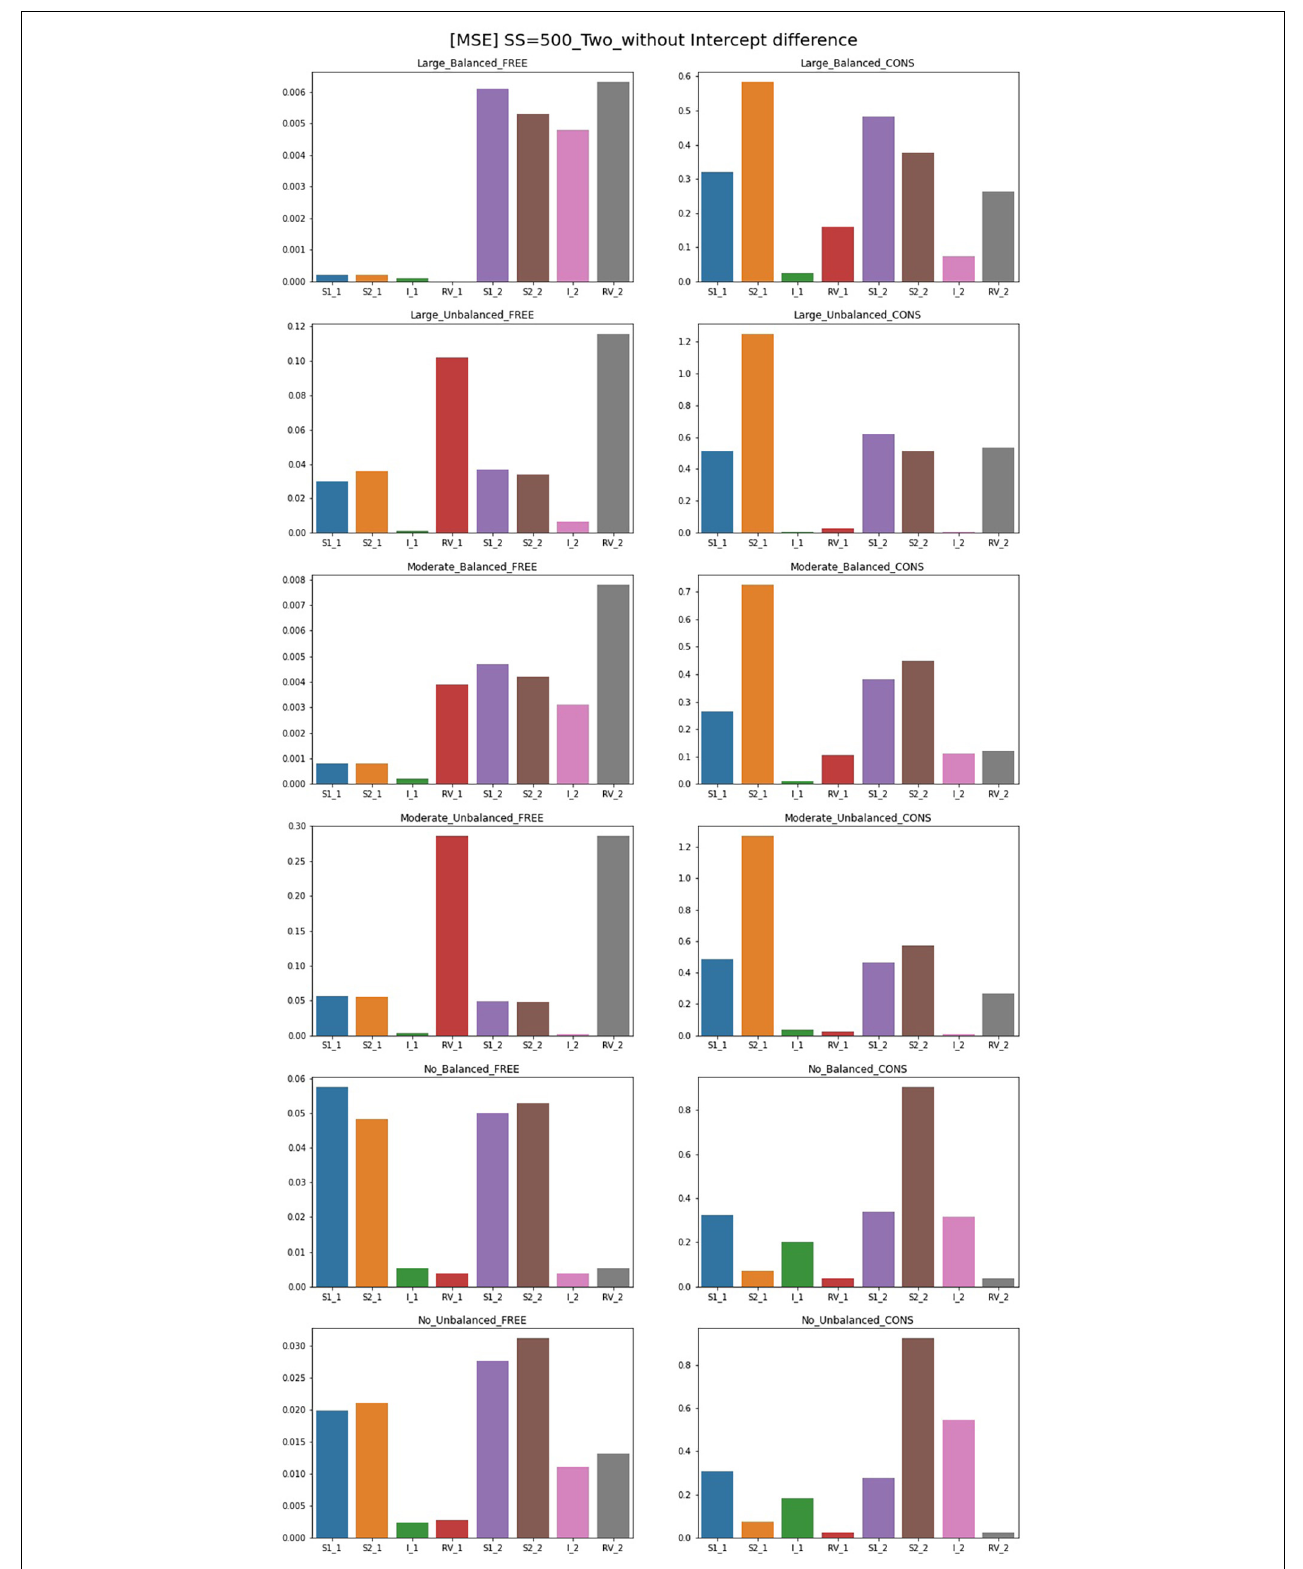
FIGURE 5 | MSE of two-predictor models (sample size = 500, without intercept difference). Free, residual variances freely estimated; Cons, residual variances equally constrained; S_1, slope for class 1; RV_1, residual variance for class 1; S_2, slope for class 2; RV_2, residual variance for class 2.